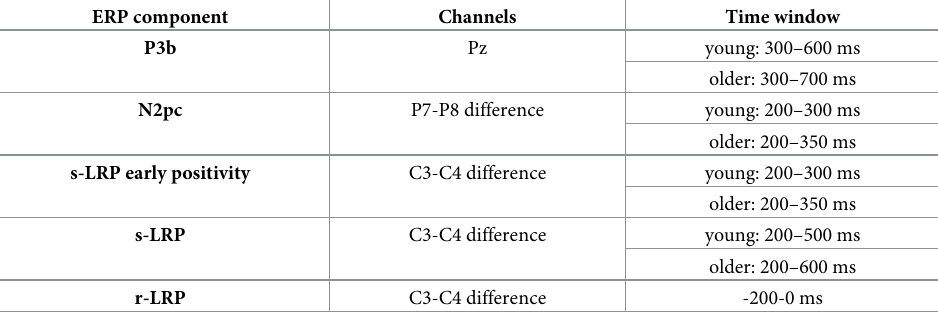
Table 1. Channels and time windows for ERP components’ amplitudes and